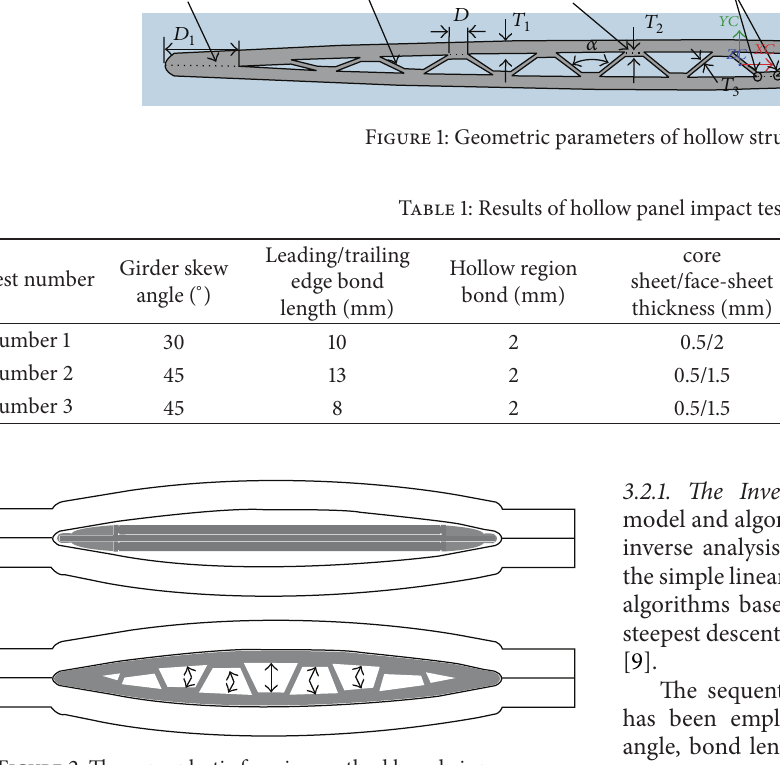
Figure 2: The superplastic forming method based air pressure.